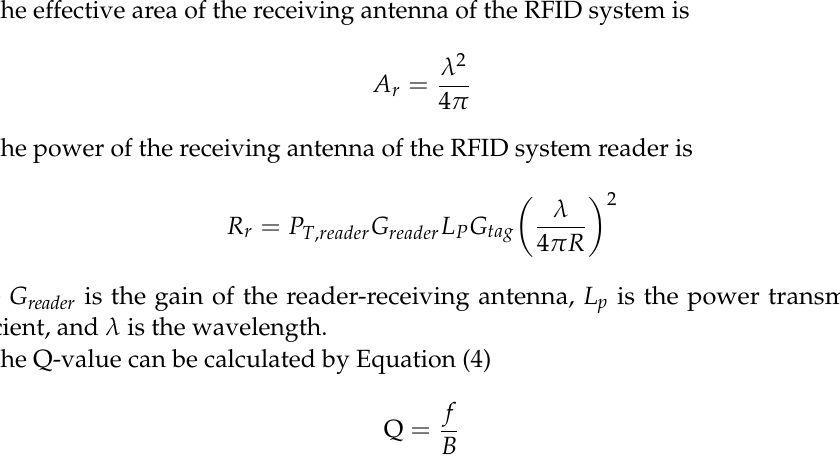
Figure 3. Structure of U-shaped resonators chipless tag: ( a ) Top view; ( b ) Side view. 3. Design and Simulation of the Chipless Tag for U-Shaped Slot Resonators